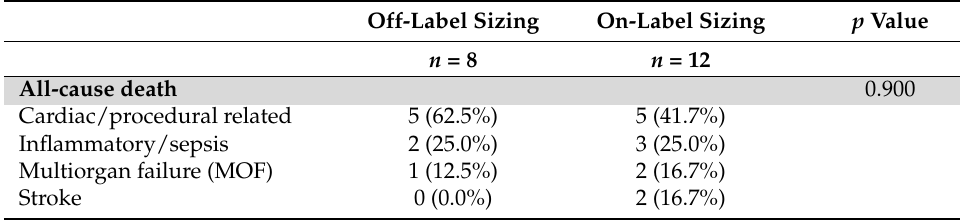
Table 3. Reason for death up to 30 days.